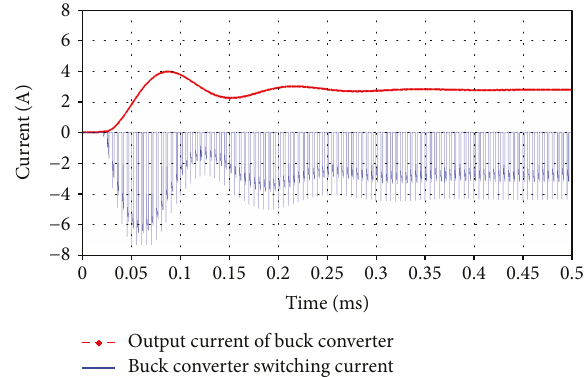
Figure 9: Input and output current waveforms for 80 V input.